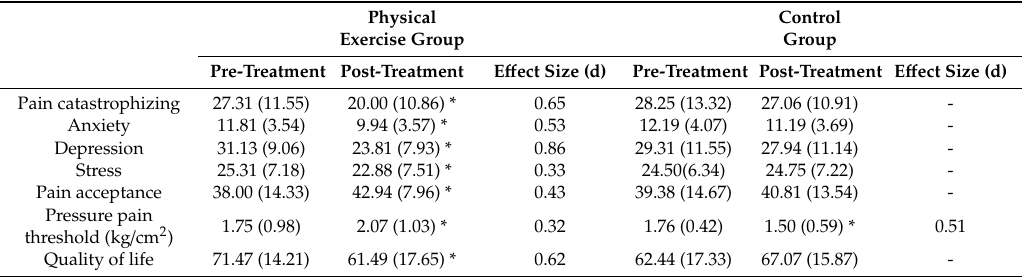
Table 2. E ff ect of the intervention on the psychological constructs, perception of pain, and quality of life.